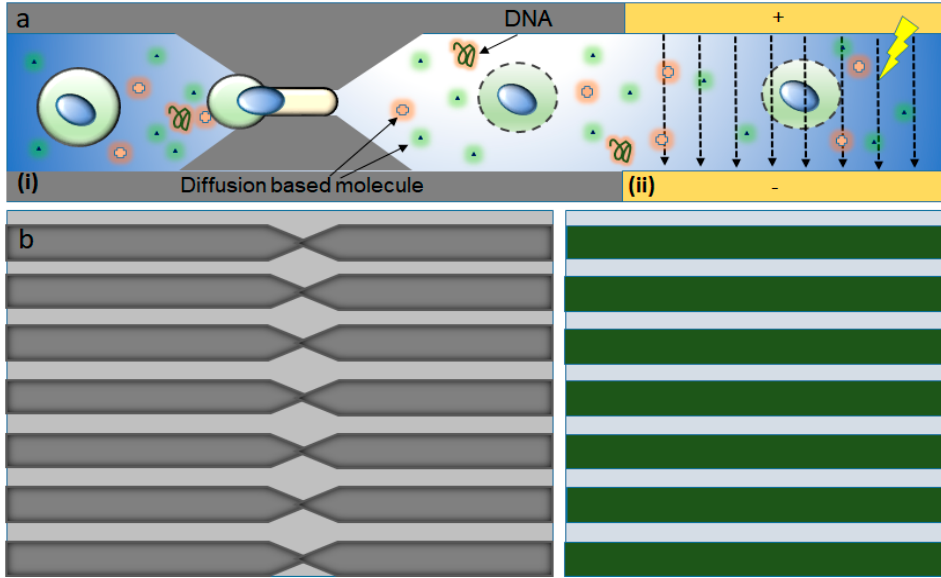
Figure 6. Mechano-electroporation device design and working principle. ( a ) Illustration of the working mechanism ( i ) mechanoporation as the cell moves through the constriction and ( ii ) the electric pulses applied driving DNA into the cytoplasm and nucleus through the disrupted membrane. ( b ) Magnified set of similar parallel microfluidic constrictions etched into a silicon wafer (left) and a set of electrodes deposited on a Pyrex wafer (right). Figure has been redrawn from ref. [87].